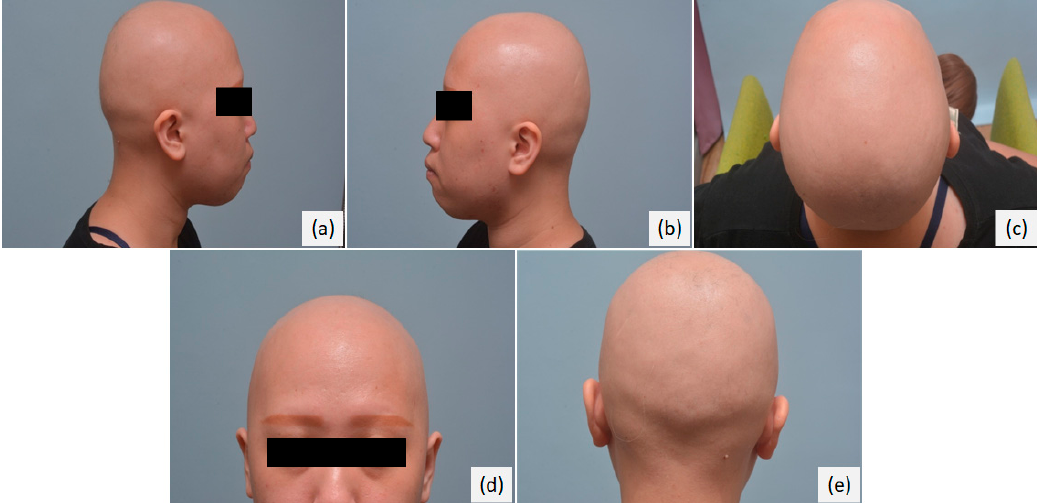
Figure 1. The pictures of patient before 1064 nm ps-Nd-Yag laser treatment; ( a ) right lateral view, ( b ) left lateral view, ( c ) vertex view, ( d ) anterior view, ( e ) posterior